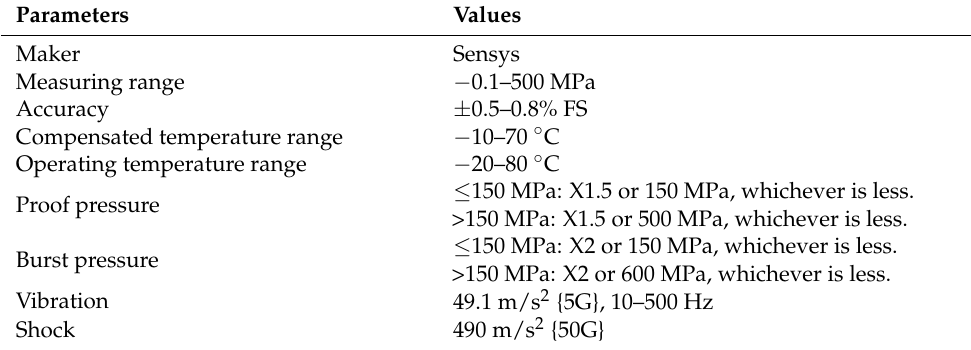
Table 1. Specification of the digital pressure